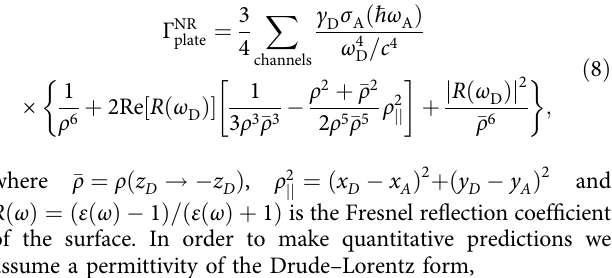
= c (cid:6) 1 ð Þ limits, D